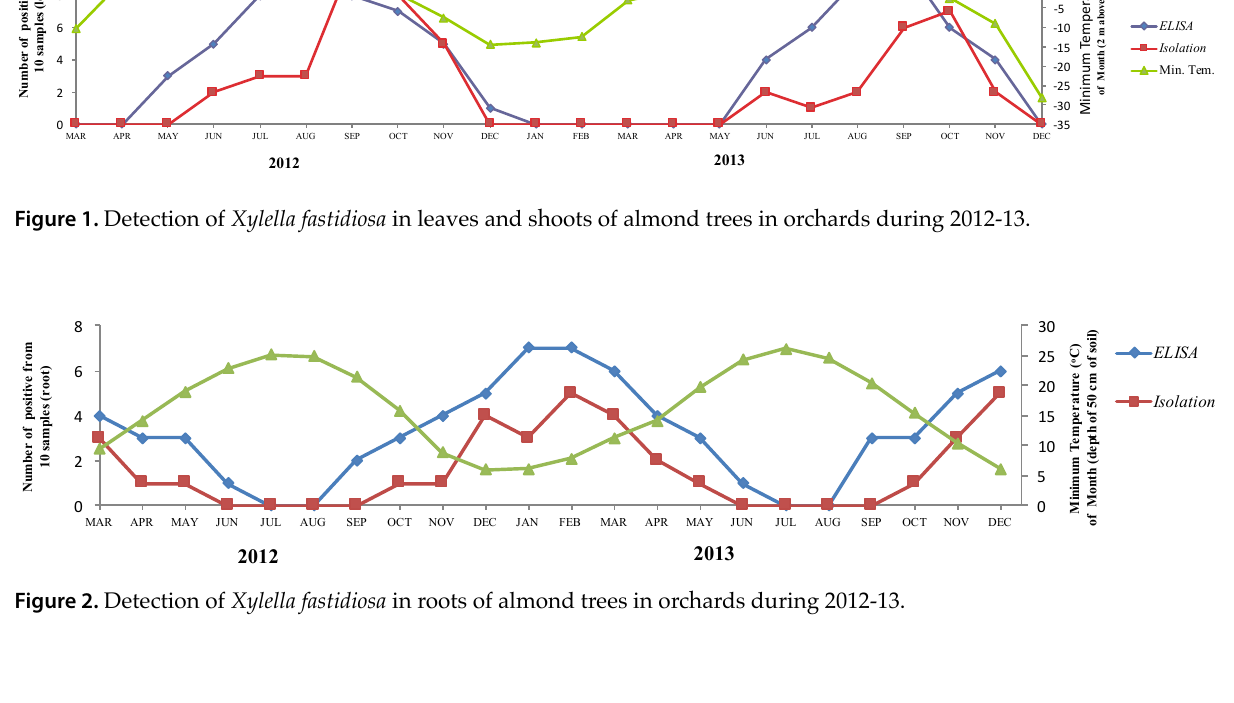
ELISA Isolation Min. Tem.